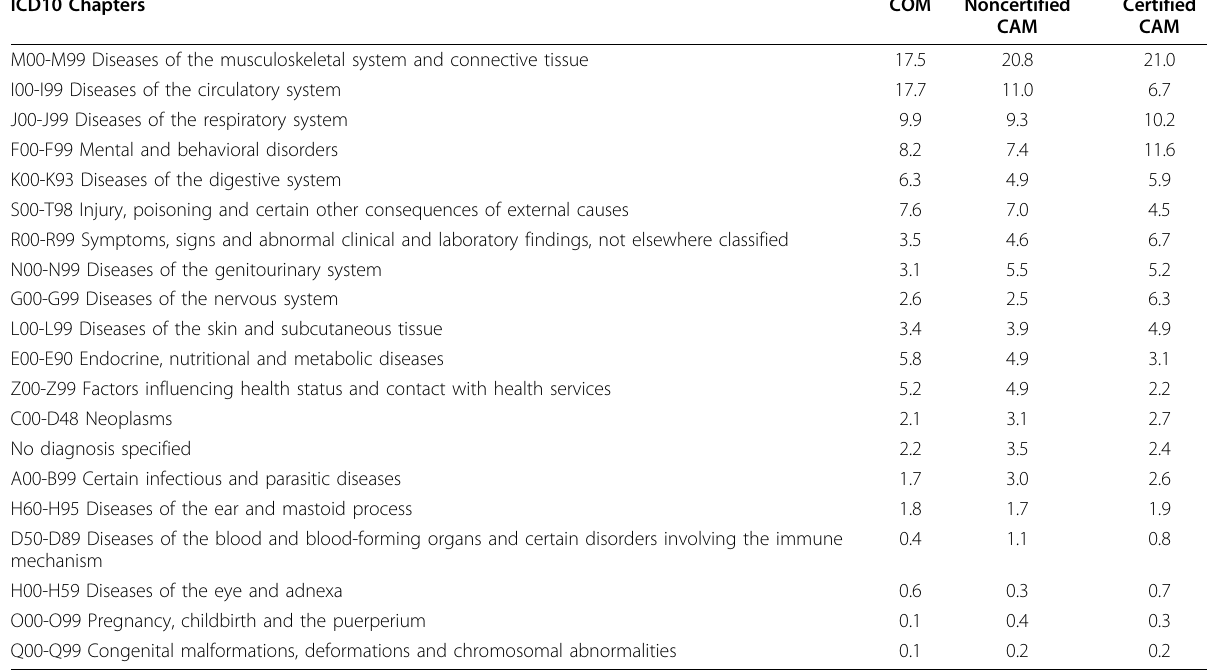
Table 3 Distribution of main diagnoses (frequency in percent per ICD10-Chapters across patient groups) ICD10 Chapters COM